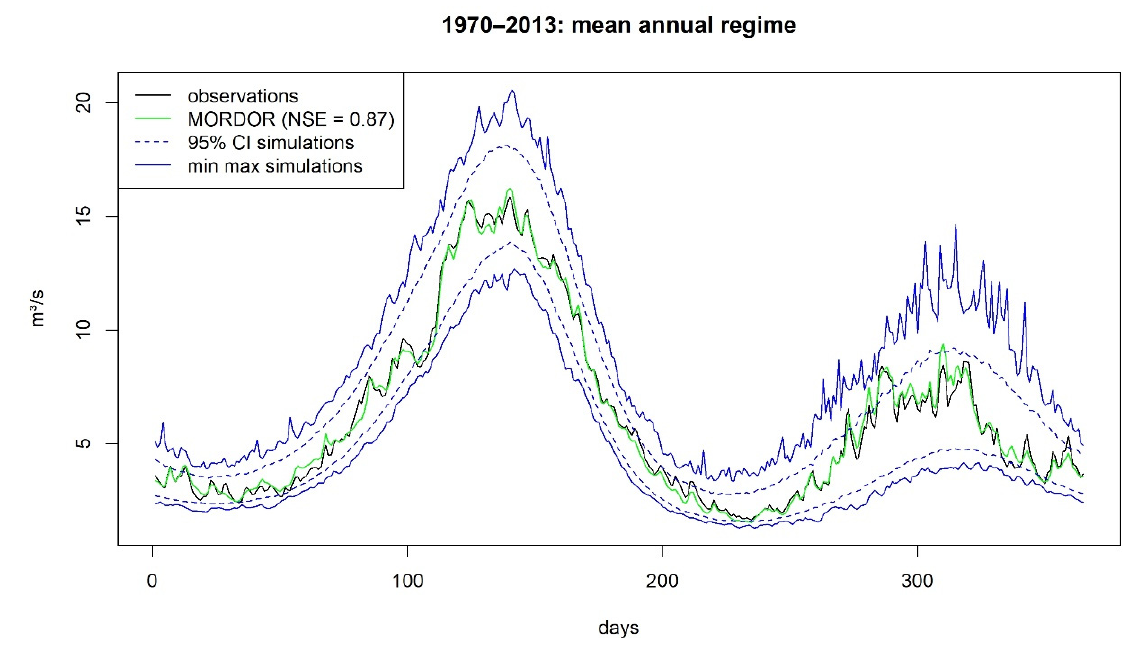
Figure 2. Observed mean annual regime over period 1970–2013 (black curve) compared to the same regime as simulated by the MORDOR model using observed precipitation and temperature (green curve) and to the range of the 1000 simulations (blue curves: simulated minimum and maximum regimes, dotted 95% confidence interval obtained from the simulations).